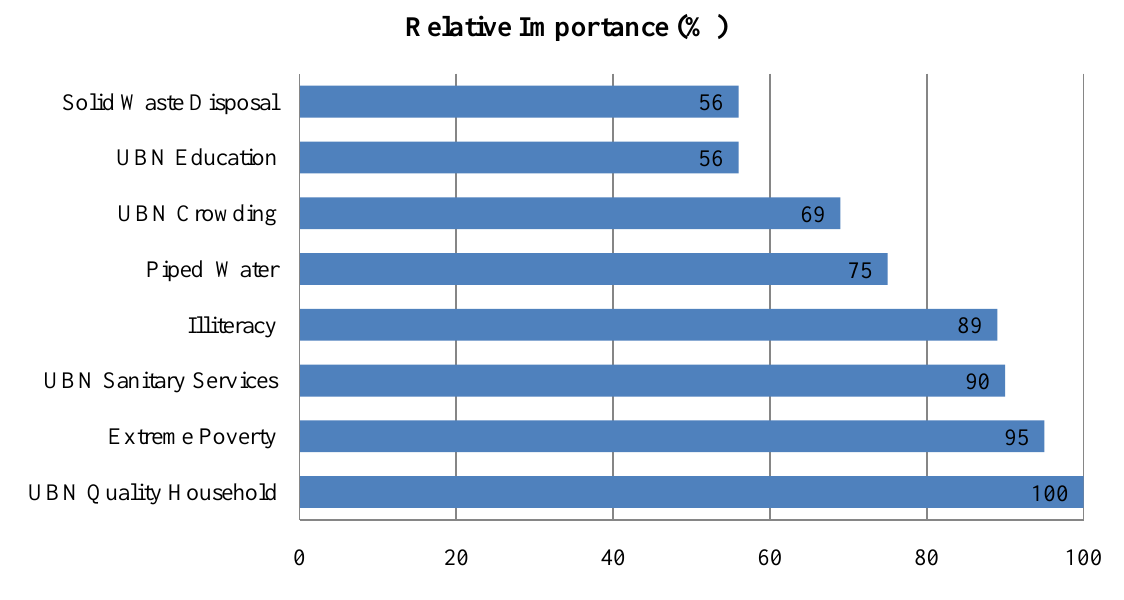
Figure 1. Relative importance of the variables in the definition of the clusters of municipalities.